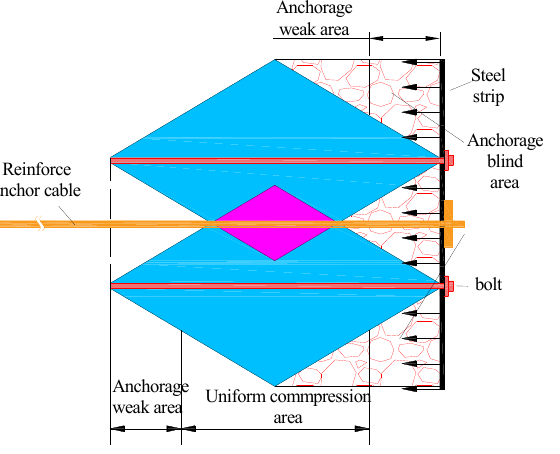
Figure 8. Supporting effect of anchor cable and anchor belt on broken surrounding rock.